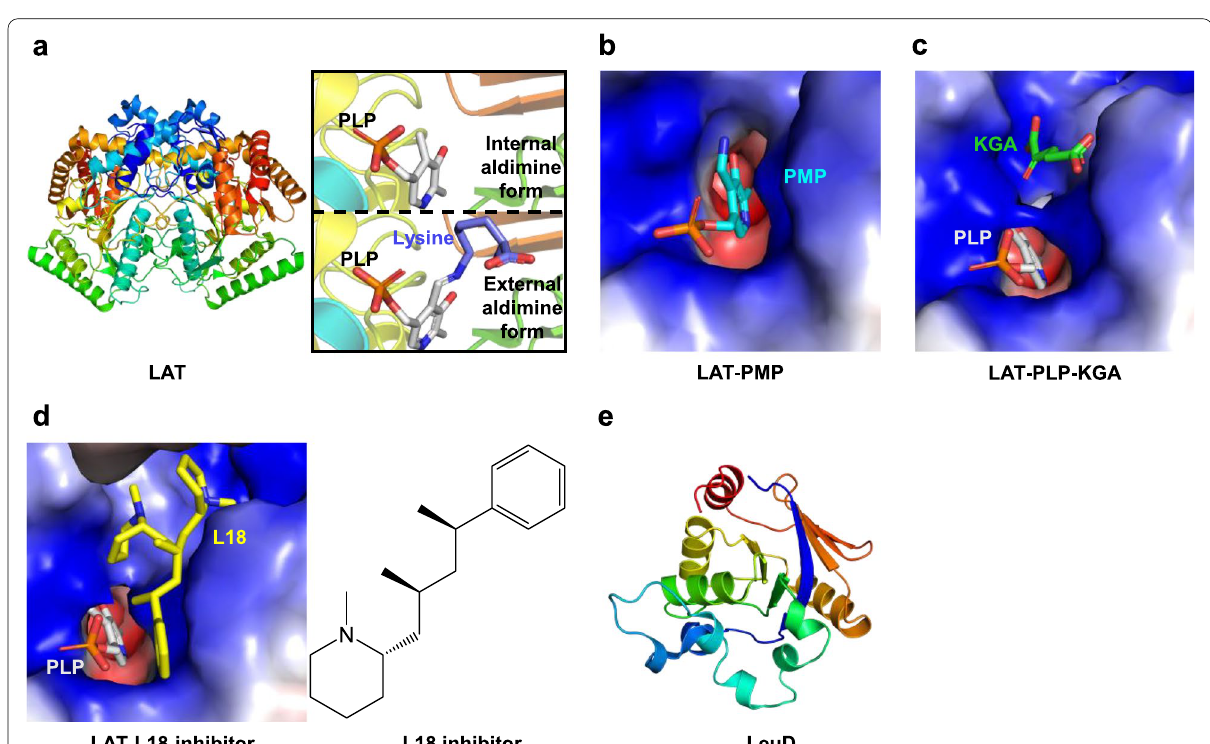
Fig. 5 Enzymes associated with amino acid metabolism. a Structures of lysine-ε amino transferase (LAT) in the internal aldimine form (PDB ID: 2CIN) and external aldimine form (PDB ID: 2CJD). PLP, pyridoxal-5 ′ -phosphate. b , c Electrostatic surface of LAT in complex with substrate PMP (PDB ID: 2CJG) and KGA in the external aldimine form (PDB ID: 2CJH), respectively. PMP, pyridoxamine 5 ′ -phosphate; KGA, α-ketoglutarate. d Electrostatic surface of LAT in complex with inhibitor L18 (PDB ID: 2JJG). L18, (2S)-1-methyl-2-[(2S,4R)-2-methyl-4-phenylpentyl]piperidine. e N-terminal structure of isopropylmalate isomerase (LeuD1–186, PDB ID: 3H5H). The electrostatic potential in all figures was computed using the APBS tools in PyMol (http:// www. pymol.